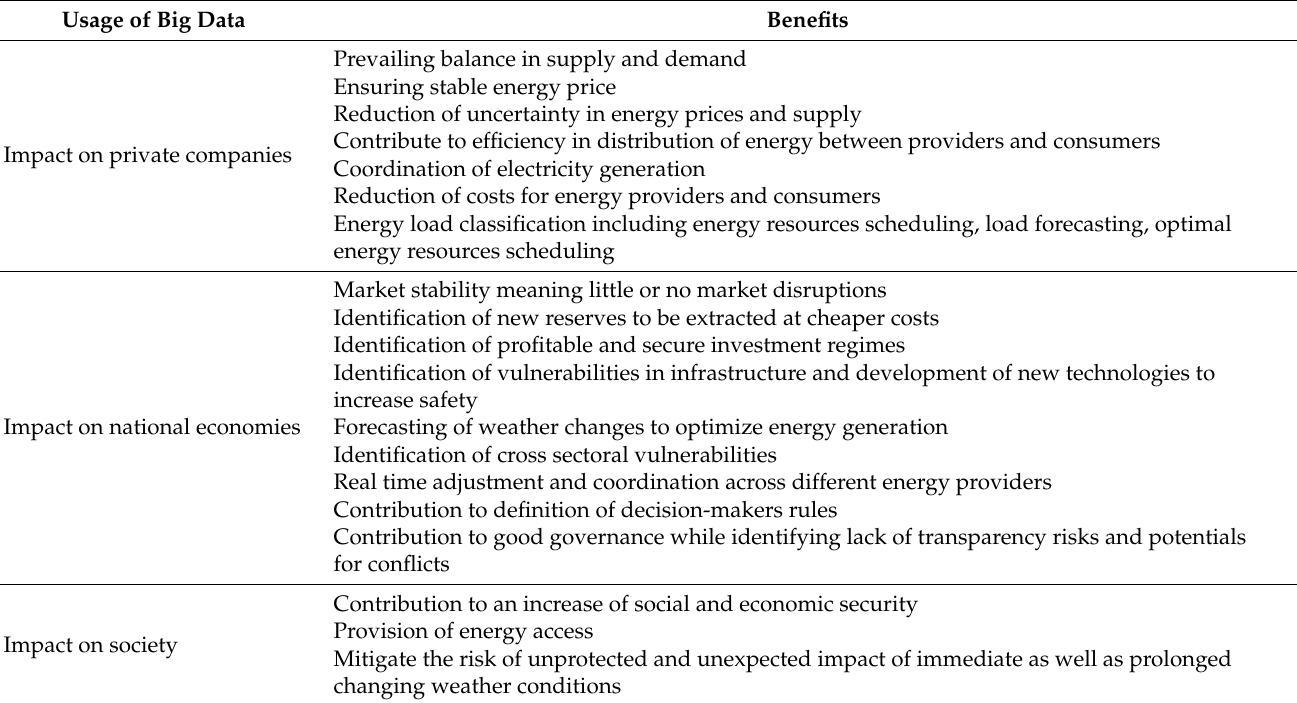
Table 3. Benefits from the usage of Big Data.